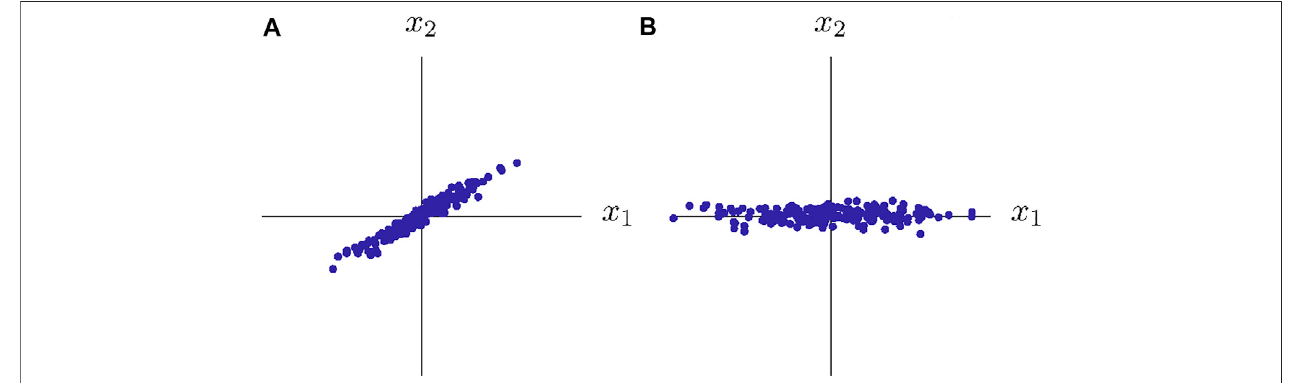
FIGURE 6 | Feature decoupling using the PCA. The PCA identi fi es the directions with the highest variance in the original data (A) and enables the extraction of linearly independent features (B)